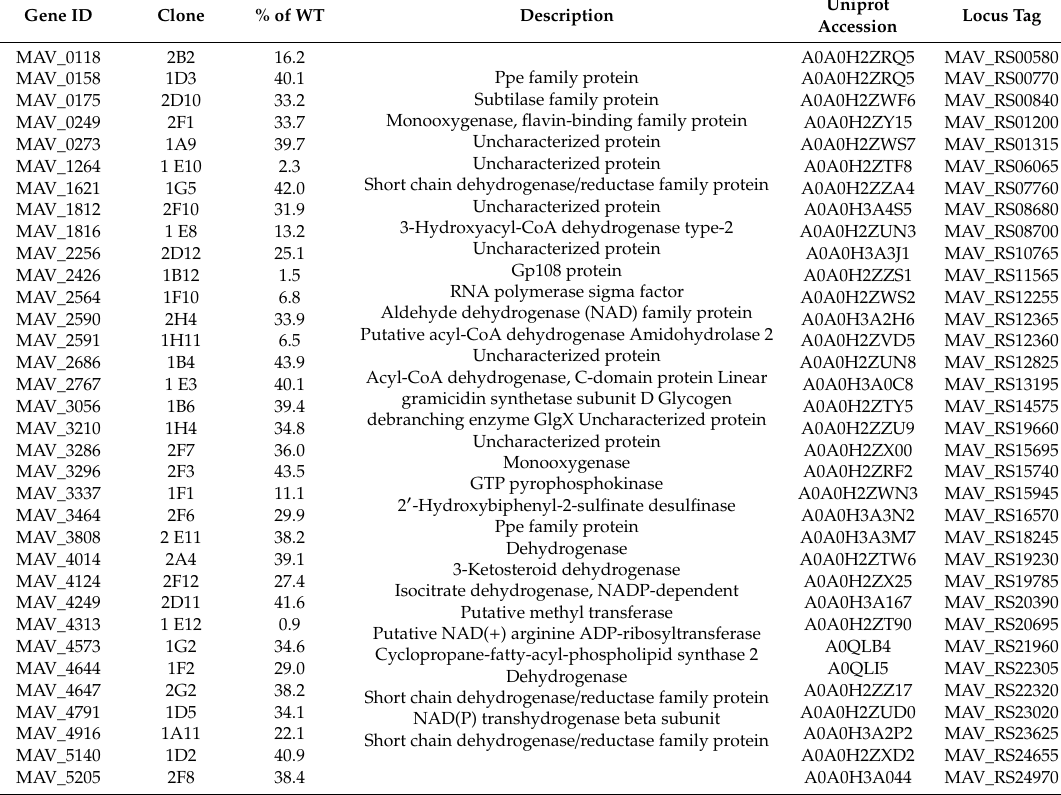
Table 1. The list of the nitric oxide susceptible Mycobacterium avium subspecies hominissuis (MAH) mutants. MmT7 knockout clones were identified as those with 50% or less optical density when compared to the wild-type MAH after 48 h of growth in 7H9 broth supplemented with 10% OADC and 100 µ M spermine NONOate. MmT7 transposon insertion sites were identified by LM-PCR and Sanger